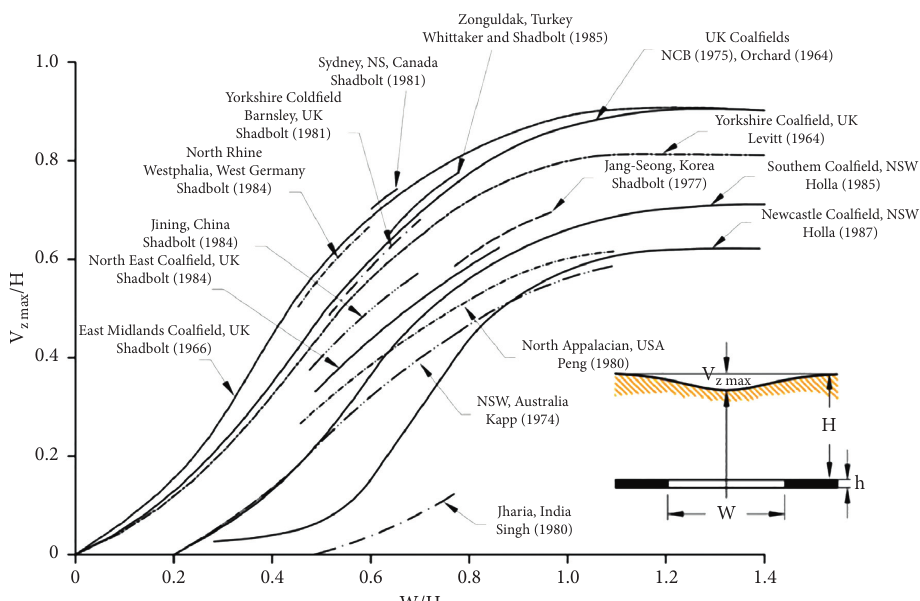
Figure 23: Influence of width-to-depth ratio on maximum vertical surface subsidence [25].